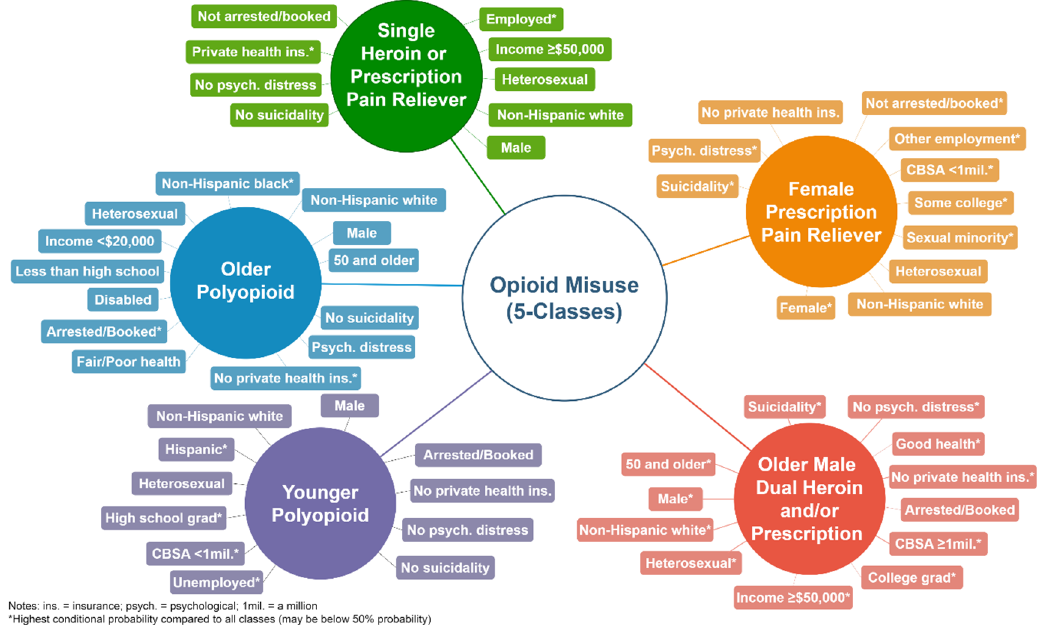
Figure 2. Opioid misuse latent classes with highest conditional probabilities within and between profiles. Within profile conditional probabilities are shown if above 50%.